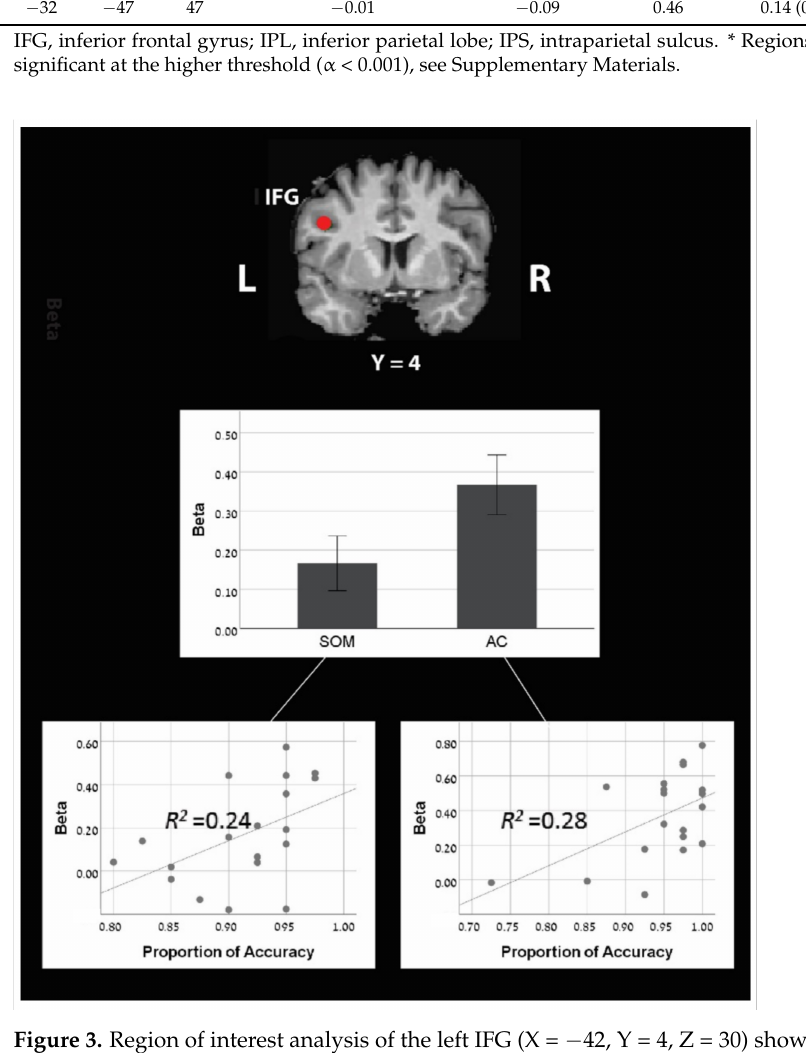
Figure 3. Region of interest analysis of the left IFG (X = − 42, Y = 4, Z = 30) shows greater activation during the approximate calculation strategy compared to the sense of magnitude strategy. Addition- ally, a positive correlation was found between accuracy in computational estimation and activity level both for AC and SOM